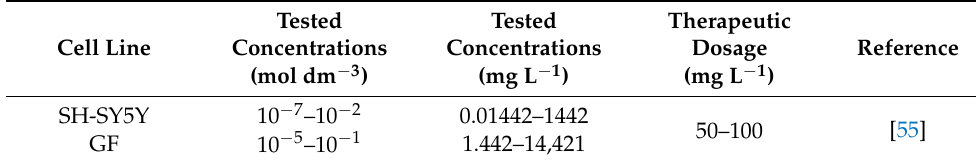
Table 1. Therapeutic dosage of valproate drug.